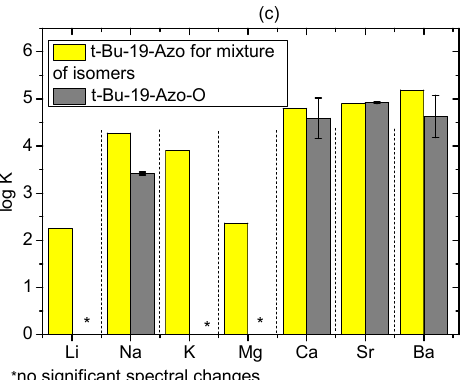
Figure 18. Comparison of the stability constant values (logK) of complexes of t -Bu-19-membered crowns: ( a ) t -Bu-19- p -OH , t -Bu-19- o -OH and t -Bu-19-Azo ; ( b ) t -Bu-19-Azo and 19-Azo [14,15]; ( c ) t -Bu-19-Azo and t -Bu-19-Azo-O with metal perchlorates in acetonitrile.